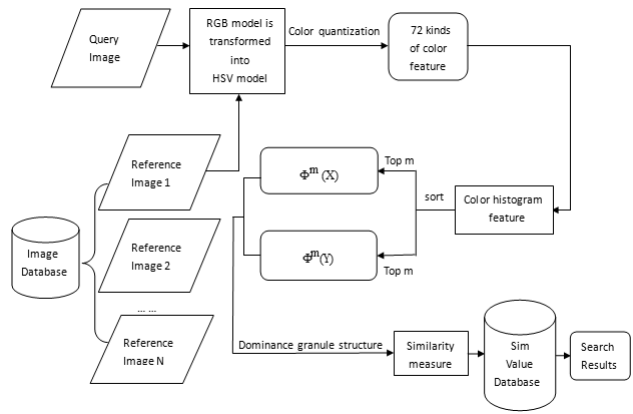
Figure 2. The framework of the content-based image retrieval using proximity space